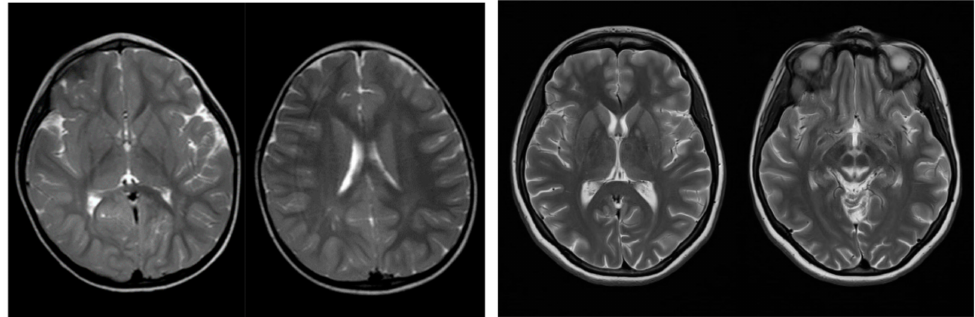
Figure 1. Axial T2-weighted magnetic resonance images of P1 ( left panel ) and P2 ( right panel ), respectively. For P1, zones of late myelination were observed (second image of the left panel ), whereas for P2 T2 hyperintensities resembling Panda sign could be discerned (second image of right panel